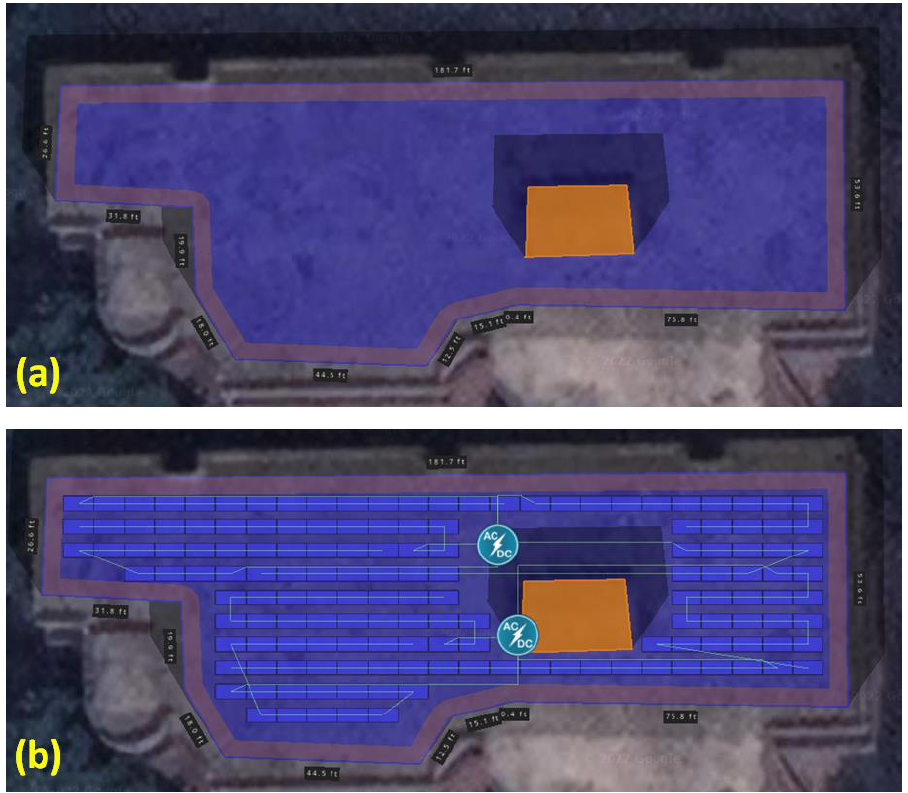
Figure 7. Images of rooftop space of the north block of the Udayan school, Dhaka ( a ) and the PV sizing obtained using the HelioScope simulation tools ( b ). Table 8. Summary of upscaling the PV sizing and possible power output obtained from Helioscope simulation performance.